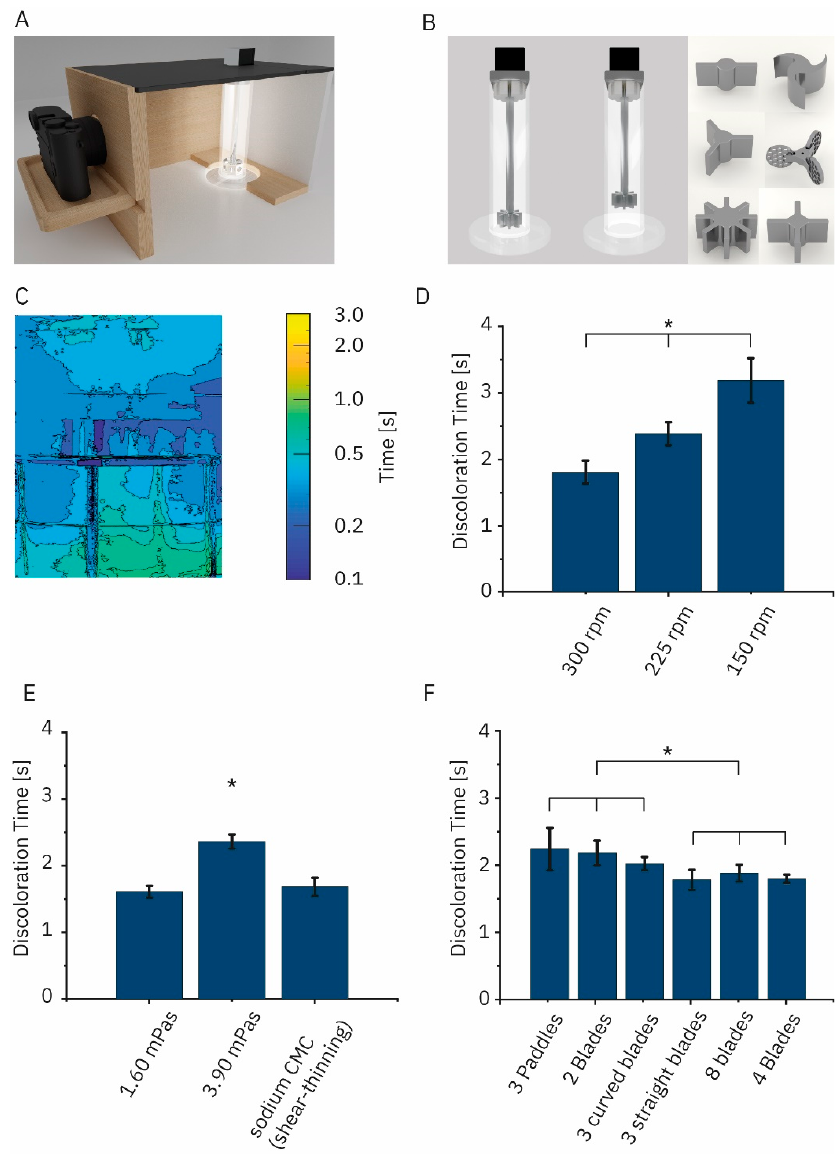
Figure 2. ( A ) Setup for the discoloration time measurement of Lugol’s solution using sodium thiosulfate solution, consisting of a mixing vessel with a stepper motor, an illuminated box with a camera mount, as well as an HD-capable camera (this is introduced in Figure 1A). ( B ) Detailed view of the mixing vessel with a rotor in the bottom position ( left ) and positioned at a ground clearance of 5 cm ( middle ). Furthermore, the six different rotor geometries evaluated are depicted ( right ). ( C ) Time until a pixel was first determined as mixed by the analysis algorithm using an eight-blade mixer rotating at 300 rpm at a ground clearance of 5 cm in water. ( D ) Discoloration time for an eight-blade mixer with different rotational speeds in water (0.89 mPa s). ( E ) Discoloration time for an eight-blade mixer in media with increasing viscosity (Newtonian) or shear-thinning (carboxymethylcellulose sodium (sodium CMC) properties at 300 rpm (we cannot report a viscosity for sodium CMC. CMC is shear thinning. The vessel has a gradient of different shear stresses. For the CMC’s shear-thinning properties, the gradient translates into a range of viscosities within the solution which was not experimentally accessible (mean ± standard deviation; * p < 0.05, ANOVA with Tukey post hoc test; n = 5). ( F ) Discoloration times in water at a ground clearance of 5 cm and a rotational speed of 300 rpm for the different rotors depicted in panel ( B ) (mean ± standard deviation; * p < 0.05, ANOVA with Tukey post hoc test; n = 5).